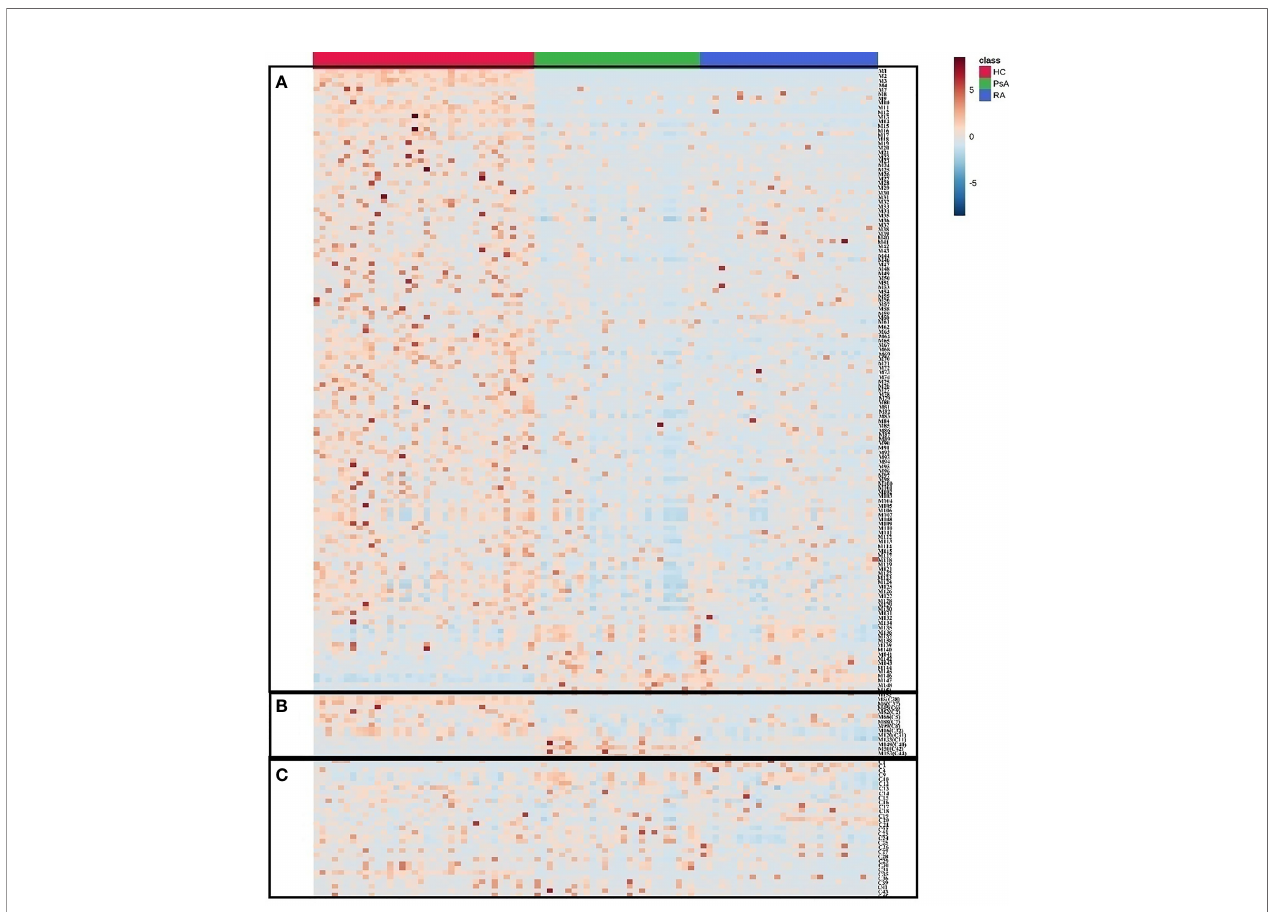
FIGURE 3 | The heatmap of differential metabolites in HC, PsA and RA groups. Red color indicates high level of metabolites and blue color indicates low level of metabolites. (A) Metabolites distinguishing HC from PsA groups; (B) Metabolites distinguishing PsA from all other groups; (C) Metabolites distinguishing PsA from RA